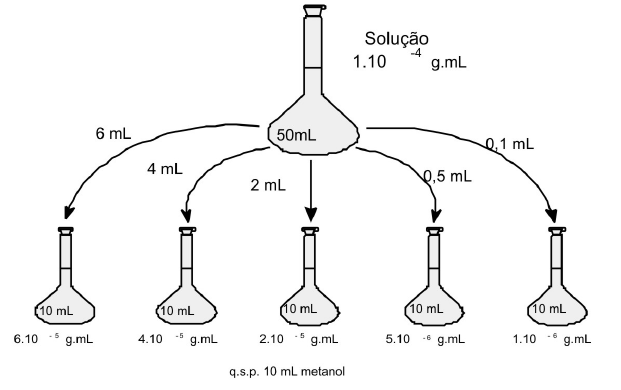
FIGURA 1 – Diluições realizadas para teste do radical